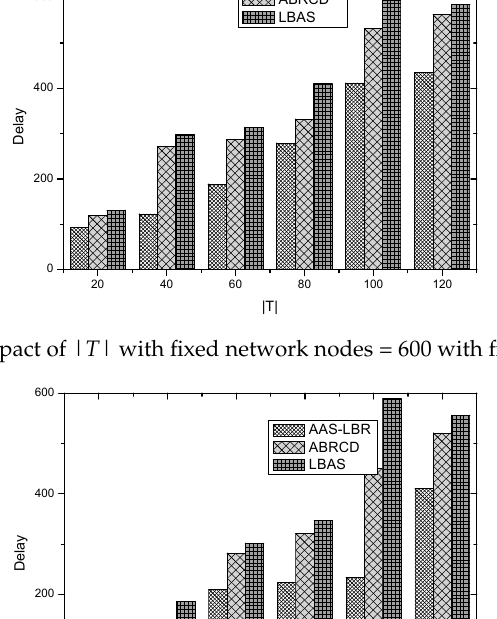
Figure 47. The impact of | T | with fixed network nodes = 400 with fixed on the delay.